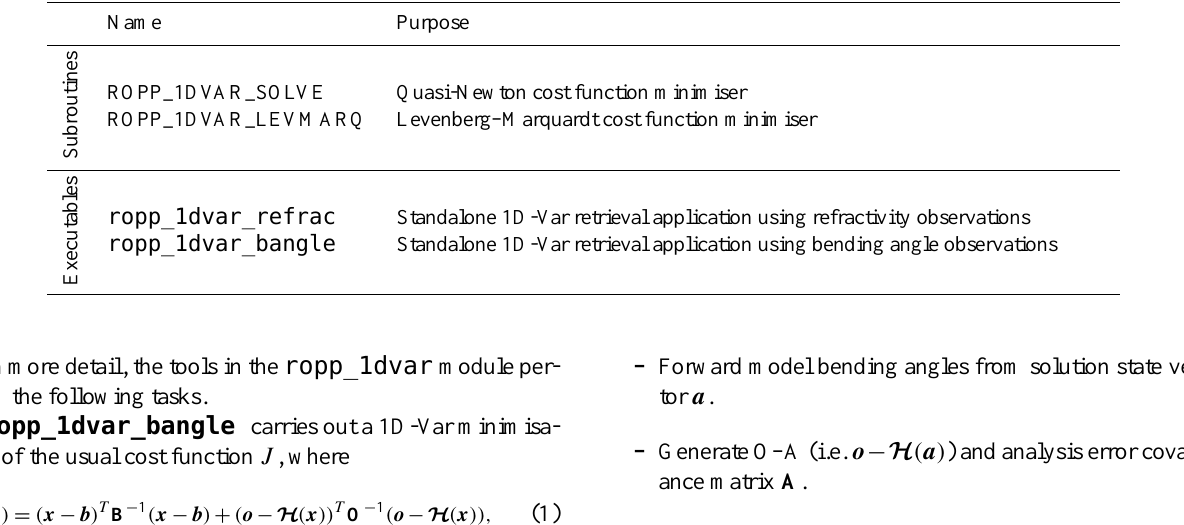
Table 6. Subroutines and standalone executables in the ROPP 1DVAR